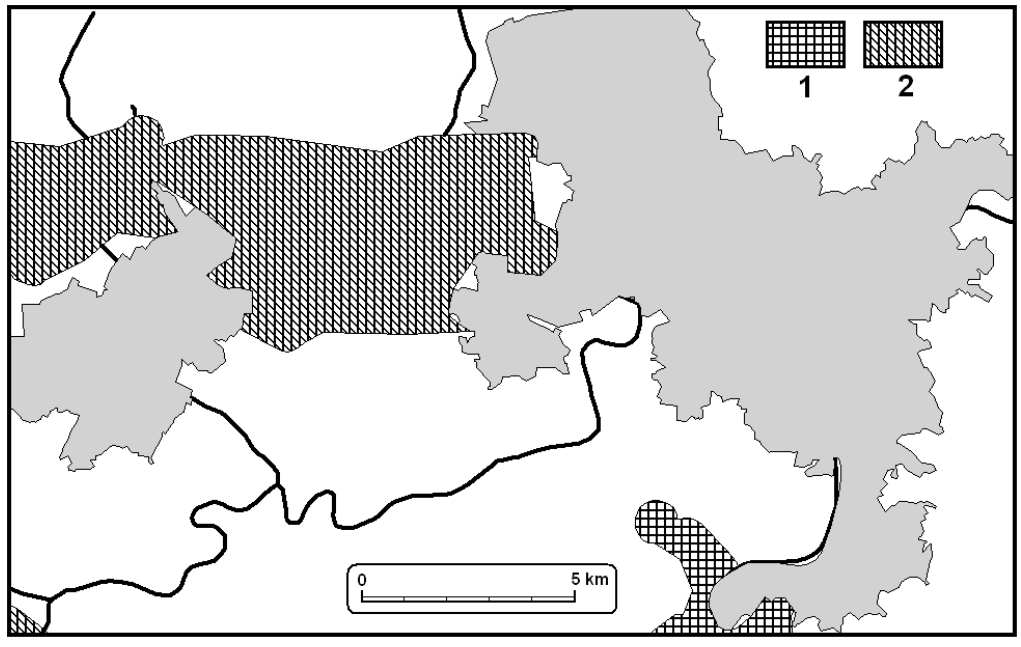
Fig. 7. Types of defined post-industrial landscapes